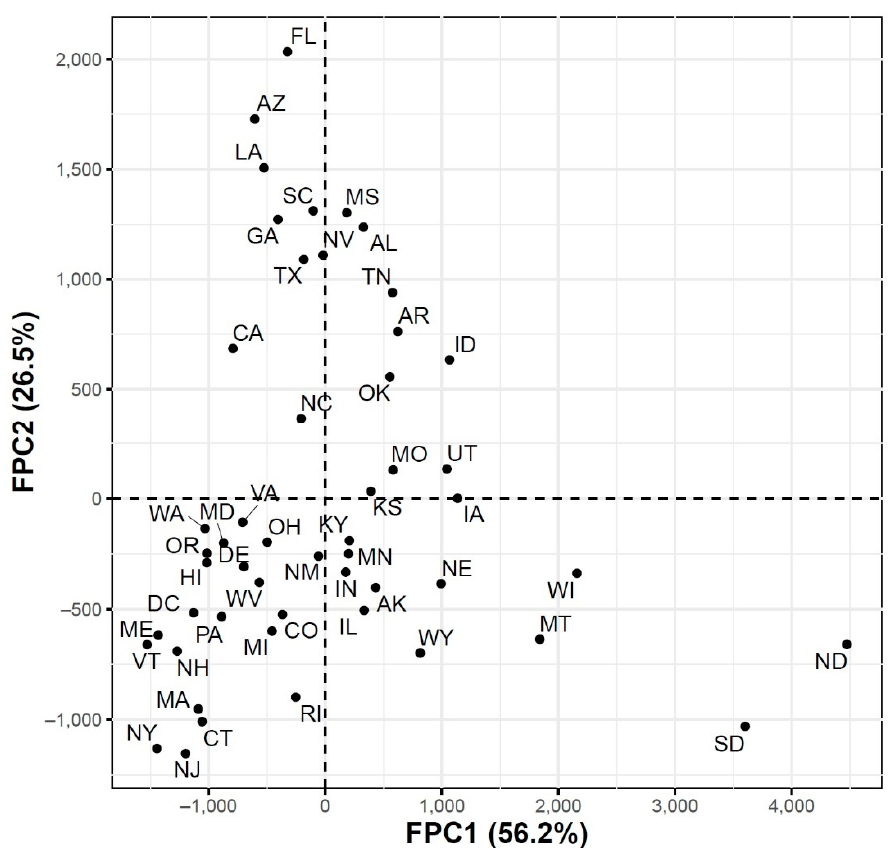
Figure 4. Scatter plot of the 51 US states in a two-dimensional space defined by the first two functional principal component scores of the COVID-19 case trajectories.